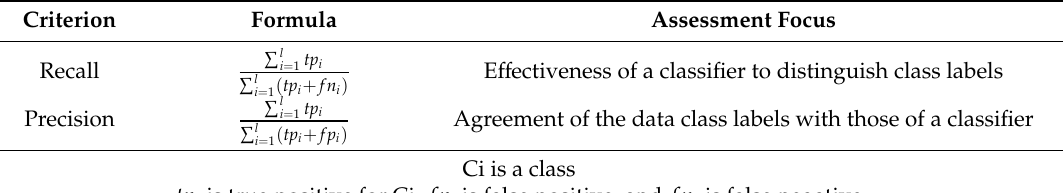
Table 4. Performance criteria used in this